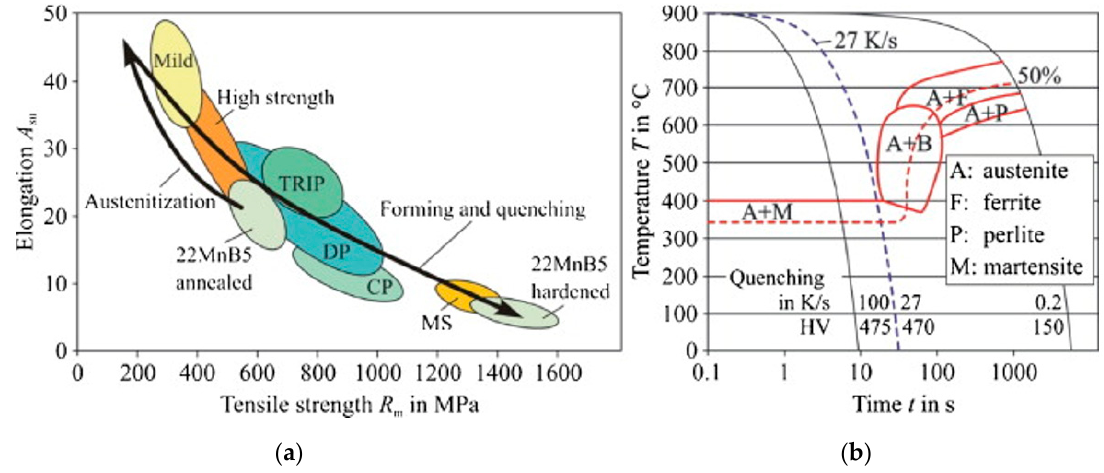
Figure 1. ( a ) Mechanical properties of 22MnB5; ( b ) CCT curve [12], with permission from Elsevier, 2020.